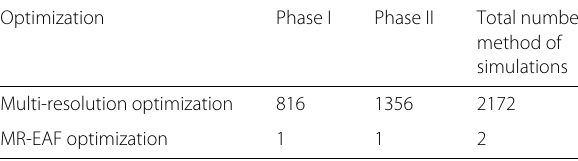
Table 4 Simulation results of no. simulations